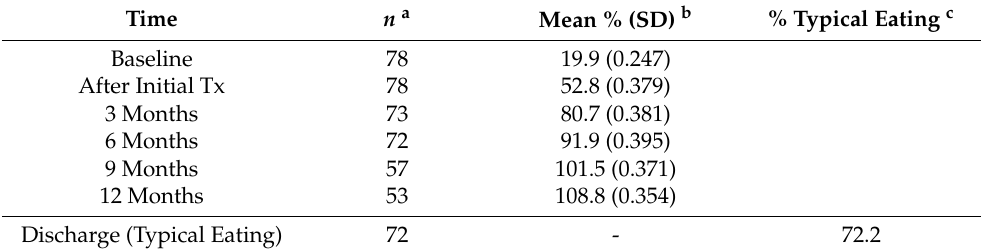
Table 2. Tube Feeding Dependent—Percentage of kcal Goal Met